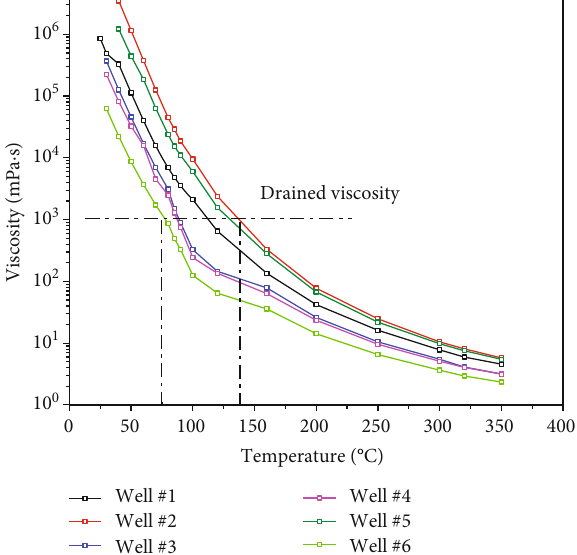
Figure 5: Relations of viscosity and temperature of Karamay